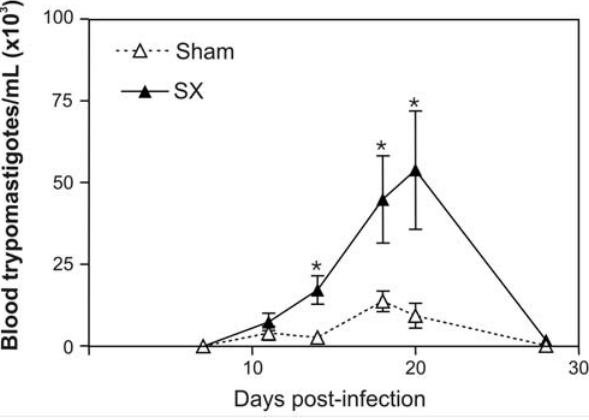
Figure 3. Splenectomy increases host’s susceptibility to T.cruzi infection. BALB/c mice were submitted to surgery to remove the spleen (SX). Sham-operated mice were used as controls. Ten days after surgery, mice were infected intraperitoneally with 2 6 10 5 metacyclic trypomastigote forms of Dm28c clone of T. cruzi . Parasitemia was followed during acute phase. In the splenectomized animals, parasit- emia was significantly higher, as compared to the sham-operated infected counterparts. Kinetic points with significant differences between SX ( n =07, filled line) and sham-operated ( n =05, dashed line) groups are indicated. Data were compared by Student’s t test for independent samples using a Sigma Plot for Windows (version 4.01) package. For parasitemia, data were transformed to parasites/ml for statistical analysis. Data were considered significant if p values were , 0.05 (*). Data represent mean 6 standard error. All experiments